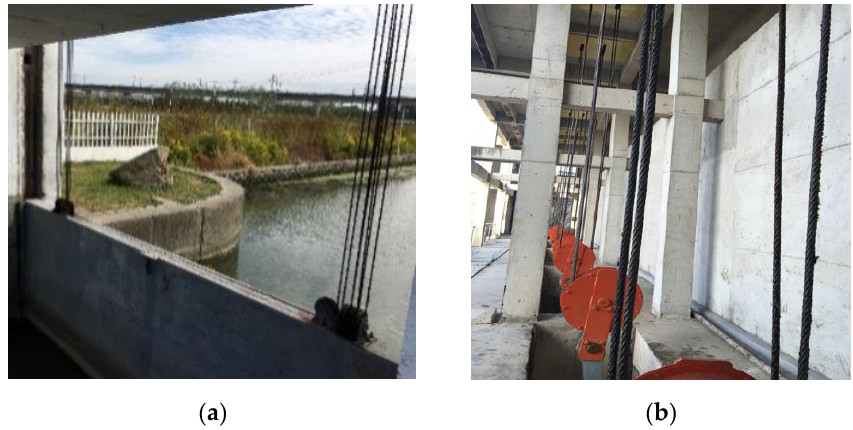
Figure 1. Sluice and wire rope working scene. ( a ) An example of the sluice used in rural river channels, and ( b ) an example of the sluice used in coastal rivers.